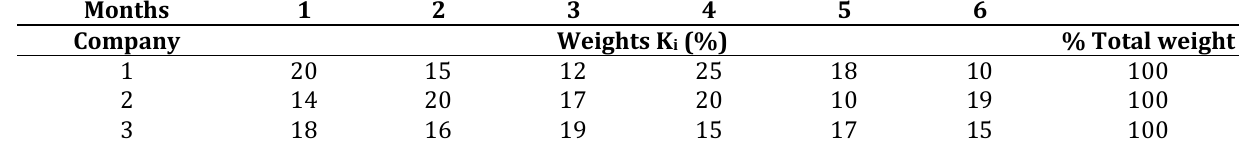
Table 1: Specified Weight of 20ft & 40ft Containers to be stuffed and delivered per month